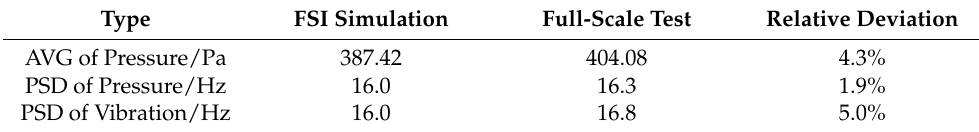
Table 2. Comparison of pressure and vibration data for the FSI simulation and the full-scale